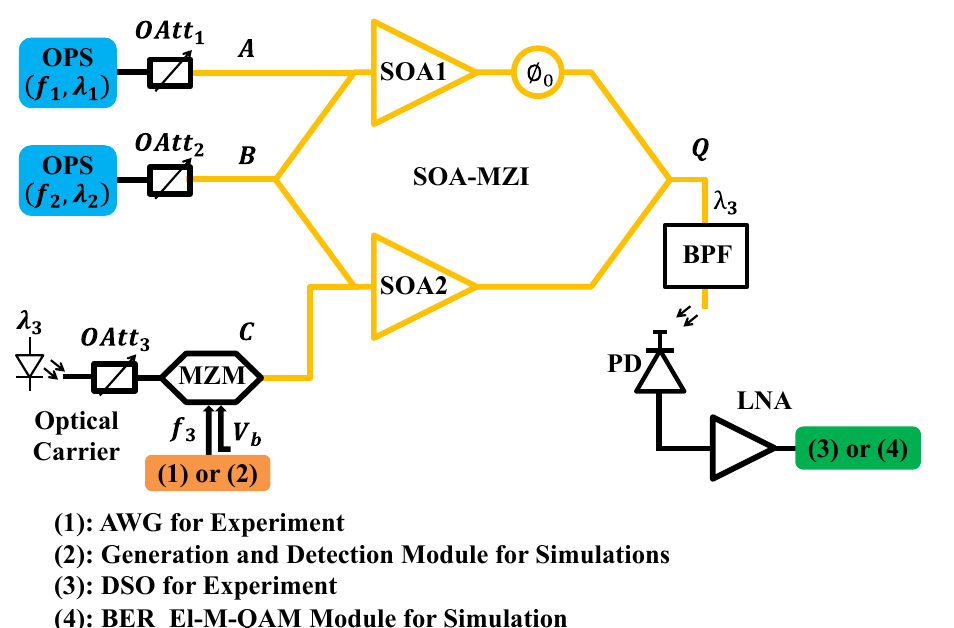
Figure 9. M-QAM “AND” setup contingent on the SOA-MZI employing differential modulation approach. AWG: Arbitrary Waveform Generator, DSO: Digital Sampling Oscilloscope, BER: Bit Error Rate, 𝑽 𝒃 : Bias Voltage, and MZM: Mach-Zehnder Modulator. The other initialisms are described as in Figure 5.